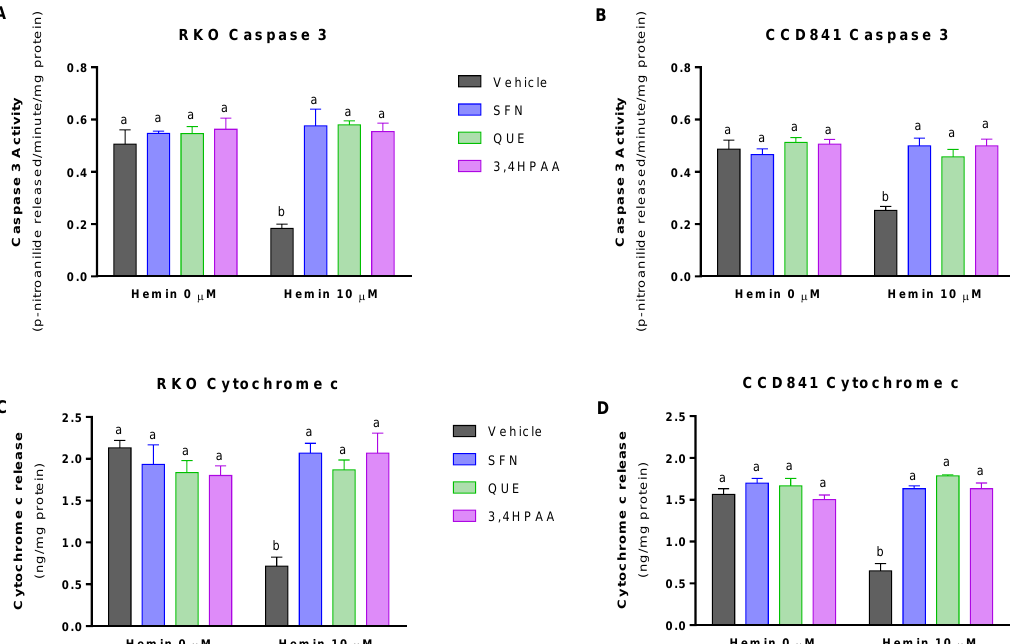
Figure 2. E ff ect of hemin, SFN, QUE and 3,4HPAA in apoptosis. Cells were incubated with vehicle (0.4% DMSO), 1 µ M SFN, 10 µ M QUE or 2.6 µ M 3,4HPAA in the absence or presence of 10 µ M hemin. After 72 h, caspase 3 activity was measured in ( A ) RKO cells and ( B ) CCD841 cells; as well as cytochrome c levels in the media of ( C ) RKO cells; and ( D ) CCD841 cells. Caspase activity and cytochrome c release were expressed as p -nitroanilide / min / mg of protein, and ng (cytochrome c) / mg of protein, respectively. Values are expressed as mean ± SEM, from three independent culture preparations. For all bars with the same letter, the di ff erence between the means is not statistically significant. Values with di ff erent letters indicate significant di ff erences ( p < 0.05) between bars (two-way ANOVA, Bonferroni post-test). 3,4HPAA, 3,4-dihydroxyphenylacetic acid; QUE, quercetin; SFN, sulforaphane.